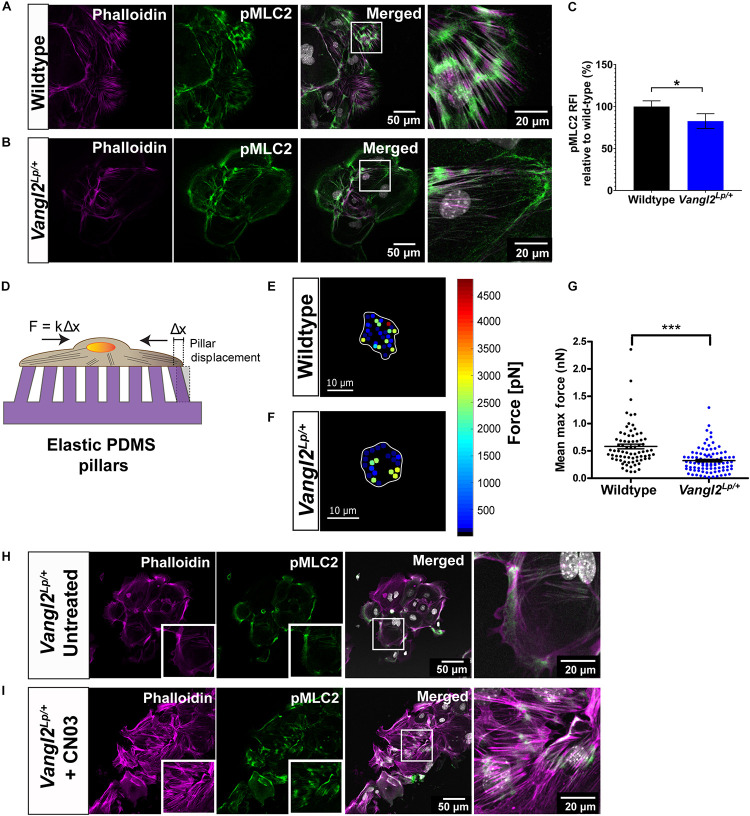
VANGL2 regulates MLC2 activation and force generation via RhoA signaling. Representative images showing wildtype (A) and Vangl2Lp/+
(B) TECs stained with pMLC2 (green) and phalloidin (magenta). Nuclei are shown in gray (DAPI). (C) Quantification of pMLC2 relative fluorescence intensity (RFI) in Vangl2Lp/+ relative to wildtype (presented as mean ± SEM). n = 3 independent experiments; TECs from three mice were pooled for each group per experiment; two technical replicates for each group per experiment; at least three fields were taken per technical replicate. Mann–Whitney U-test, *p < 0.05. (D) Schematic representation of the elastic micropillars used to measure cellular traction forces. Cells were seeded on a rat-tail collagen I coated array of micropillars and incubated at 37°C with 5% CO2 for 24 h. Individual pillar deflection from its original position in the array (Δx) is tracked via time-lapse microscopy and converted to traction force based on the pillar spring constant (k = 1.36 nN/μm). Heat maps of the traction forces distribution in a representative wildtype (E) and Vangl2Lp/+
(F) TEC. Cell boundary is outlined in white. (G) Quantification of the mean maximum traction forces exerted by wildtype (n = 75 cells) and Vangl2Lp/+ TECs (n = 92 cells) on the micropillars (presented as mean ± SEM). n = 2 independent experiments; in each experiment, tracheas from three separate mice were pooled for each group; two technical replicates for each group per experiment; each dot represents mean maximum traction force per cell. Two-tailed unpaired Student’s t-test, ***p < 0.001. Representative images showing Vangl2Lp/+ TECs without treatment (H) and Vangl2Lp/+ TECs treated with Rho activator, CN03 (I). TECs were stained with pMLC2 (green) and phalloidin (magenta). Nuclei were stained with DAPI (gray). n = 3 independent experiments; TECs from three mice were pooled for each group per experiment; two technical replicates for each group per experiment.